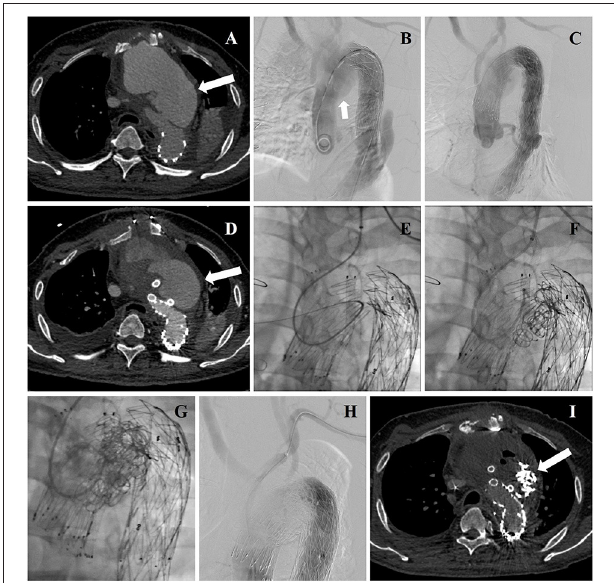
FIGURE 3 | (A) Aortic arch pseudoaneurysm (arrow) was found after TEVAR by CTA admission. (B) Intraoperative DSA identified the location of lesion again (arrow). (C) Intraoperative aortography showing deployment of aortic stent graft and CGs. (D) CTA reexamination revealed post-operative EL-I (arrow). (E) The guidewire and catheter entered into FL through gutters by choosing left brachial artery as the access artery in the second operation. (F) Coils were deployed into FL and gutters. (G) Onyx glues were deployed into FL and gutters through a microcatheter. (H) A final aortography confirmed the patency of arch branches and the exclusion of EL-I. (I) CTA examination was performed 3 months after the second operation showing that endoleak disappeared